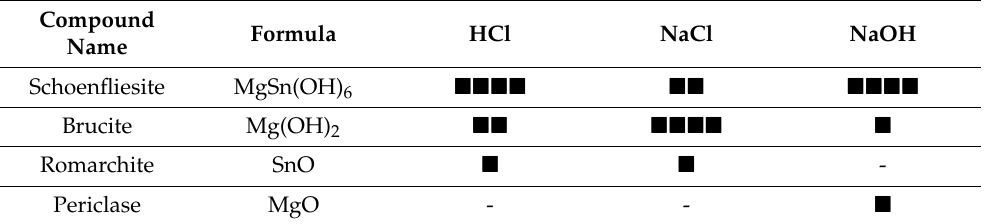
Table 5. Product phases and their relative volume fractions identified during XRD analysis of Mg 2 Sn alloy powders after corrosion. Legend: (cid:4)(cid:4)(cid:4)(cid:4) : dominant corrosion product; (cid:4)(cid:4) : lower relative amount; (cid:4) : low degree of certainty; -: not